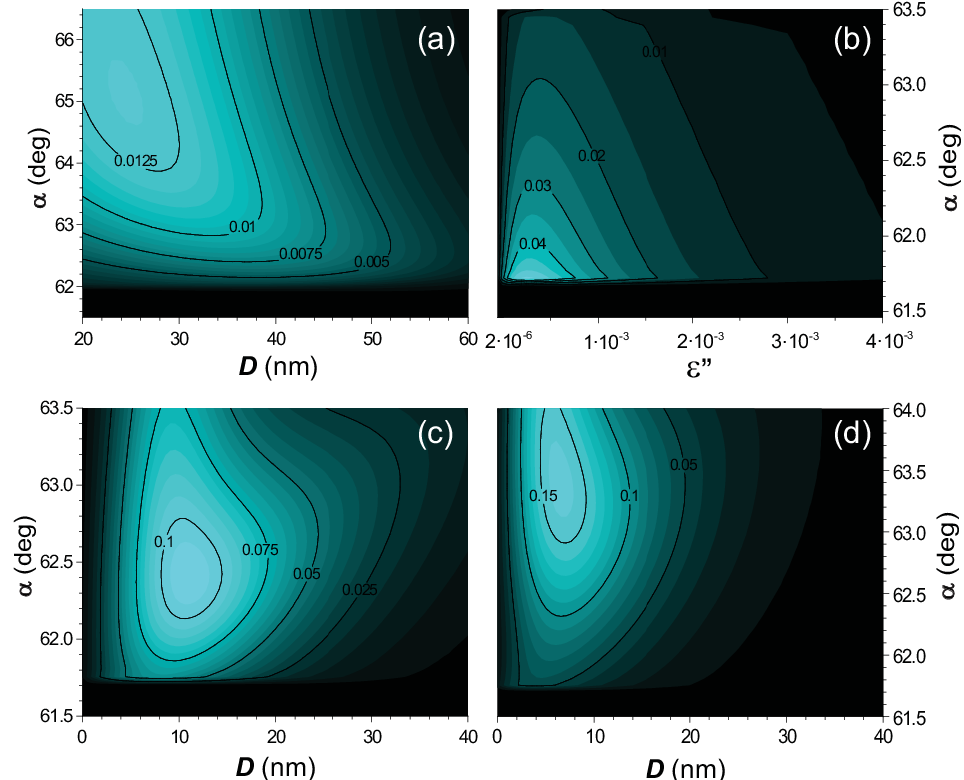
Figure 6. Diagrams illustrating the performance of SPR ( a ), SWR ( b ) and two PPhC ( c , d ) sensors, respectively. Comparison was done for the change in the refractive index of ∆ n = 1 × 10 − 3 that happened in a 20-nm-thick reaction layer on the surface of the sensors. ( c , d ) PPhC sensors without and with a 50-nm-thick SiO 2 layer covering the Au layer,